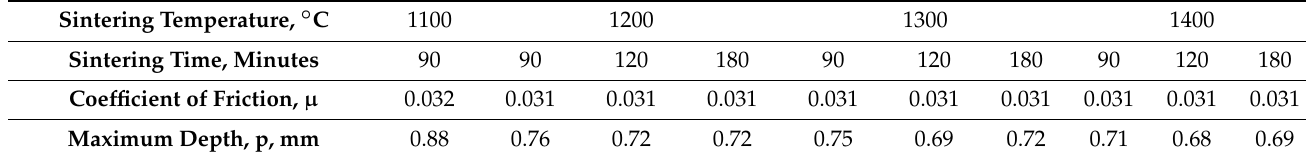
Table 7. Wear test-measured values for coefficient of friction and maximum